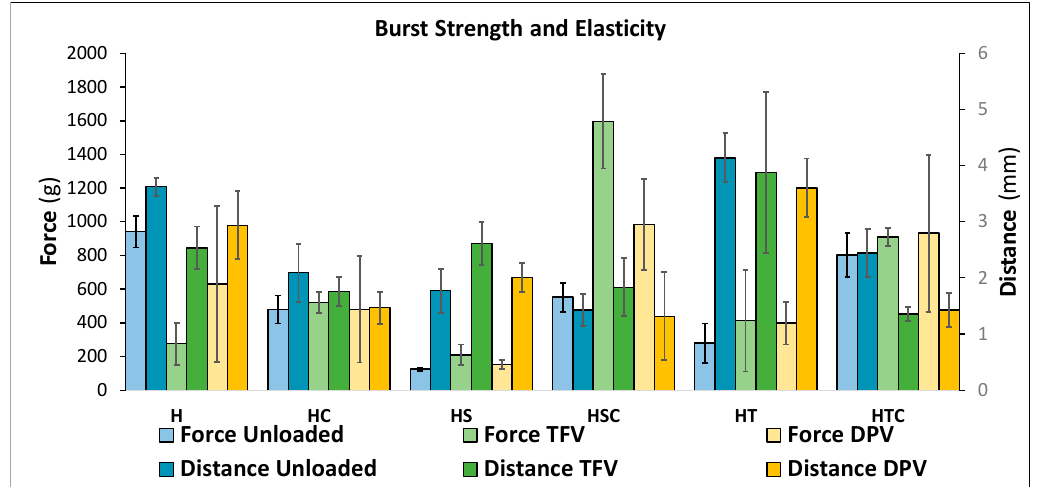
Figure 8. Burst strength and distance to burst of vaginal discs. Mean ± SD are presented ( n = 4).